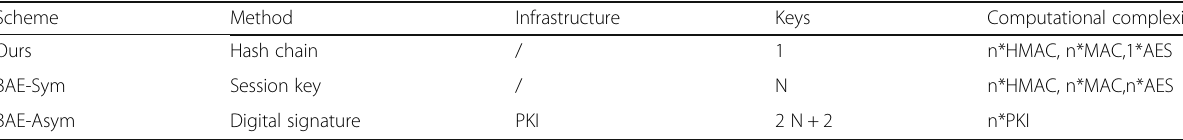
Table 2 Scheme analysis and comparison Scheme